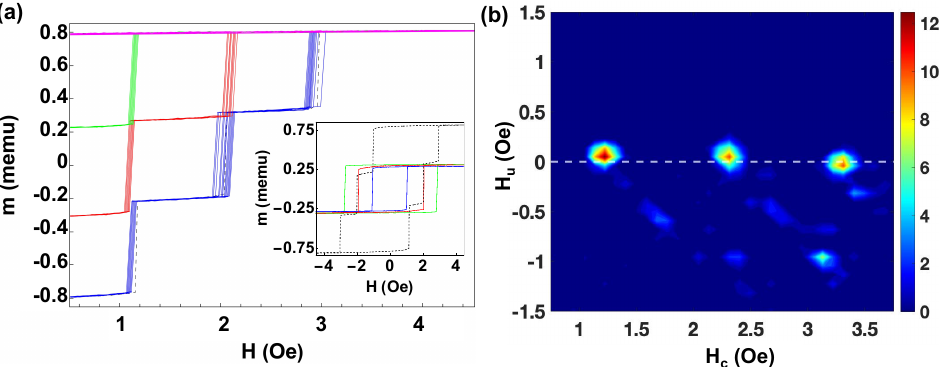
Figure 5. ( a ) FORC curves and individual MHLs (at the inset) for three Fe 77.5 B 15 Si 7.5 microwires with different coercive fields. ( b ) Corresponding FORC diagram for this set of